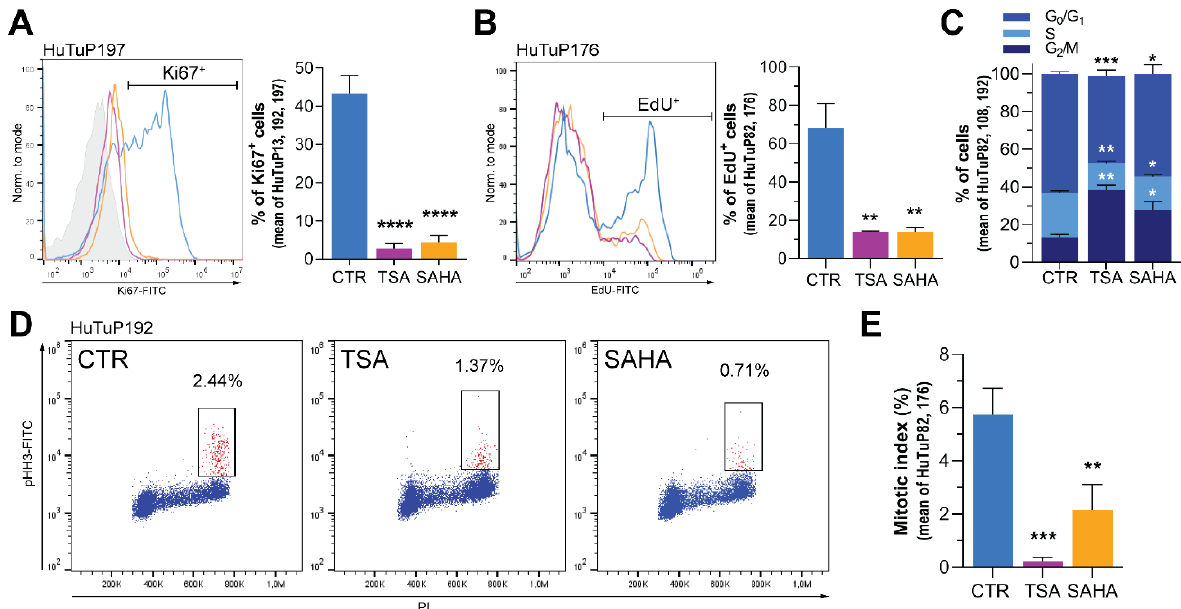
Figure 5. HDI inhibit proliferation by preventing GBM cells from proceeding in the cell cycle. ( A ) Representative flow cytometric evaluation of Ki67 in control and TSA (1 μM )/SAHA (2 μM )-treated